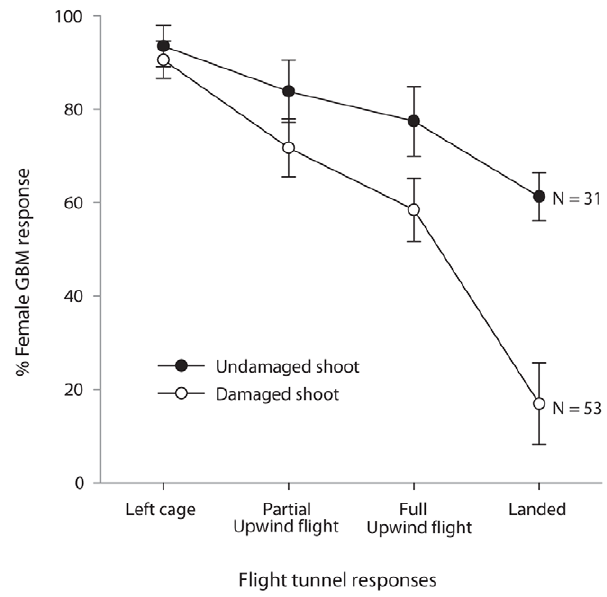
Figure 2. Effect of Japanese beetle foliar damage on female P.viteana flight response to host plant. Flight responses (% 6 1 SE ) of female P. viteana ( N =84) in the flight tunnel to Japanese beetle damaged vs. undamaged V. riparia shoots. Partial upwind flight was recorded when P. viteana made more than 50 cm of zig-zag upwind flight toward the target. Full upwind flight was the upwind flight to within 10 cm of the target.